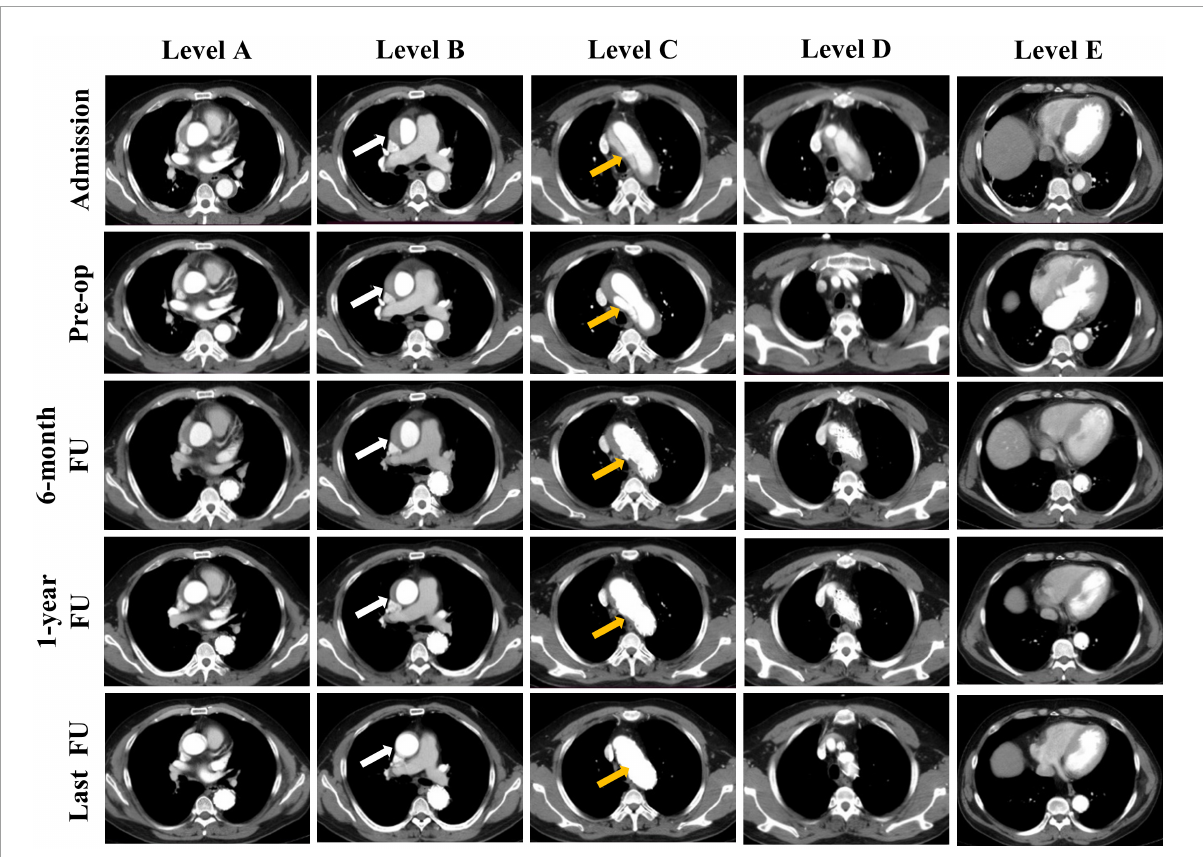
FIGURE1 Representative cases of the status of the false lumen thrombosis in different levels of the aorta. Computed tomography angiography (CTA) images show the false lumen (FL) status of a patient at admission, before operation and during follow up. Results of five levels CTA images at different time points are presented: Sinotubular junction (Level A), mid ascending aorta (Level B), proximal aortic arch (Level C), mid aortic arch (Level D), and mid descending aorta (Level E). CTA images show the FL status of the mid ascending aorta at different time points: patent, partial thrombosis, complete thrombosis, partial absorption, completely absorption (Level B, white arrow). And the entry tear was completely obliterated by stent graft (Level C, yellow arrow).